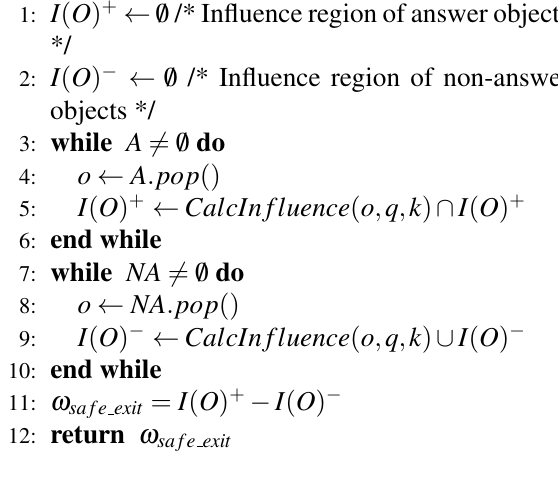
Fig. 10. ComputeSafeRegion